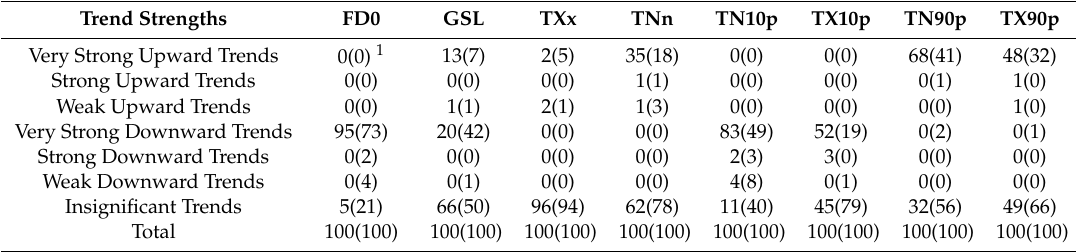
Table 2. Percentage of stations with trends strengths in extreme temperature indices (%).